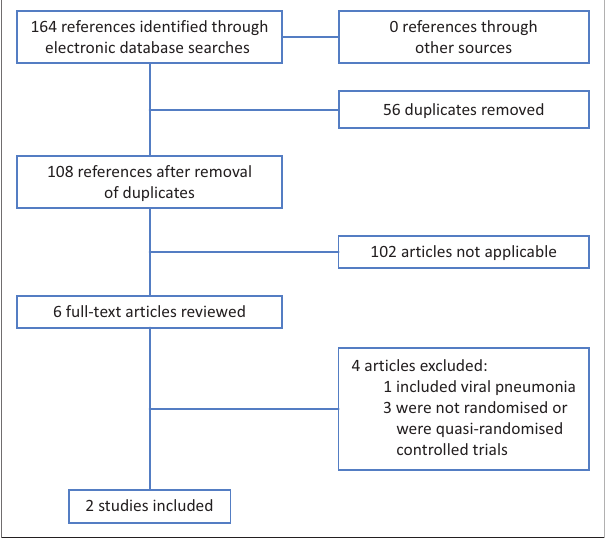
FIGURE 1: Study flow